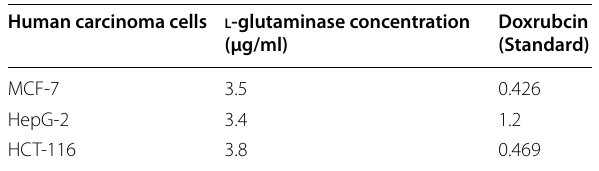
Table 4 Inhibition concentrations (IC of l -glutaminase produced by Bacillus sp.